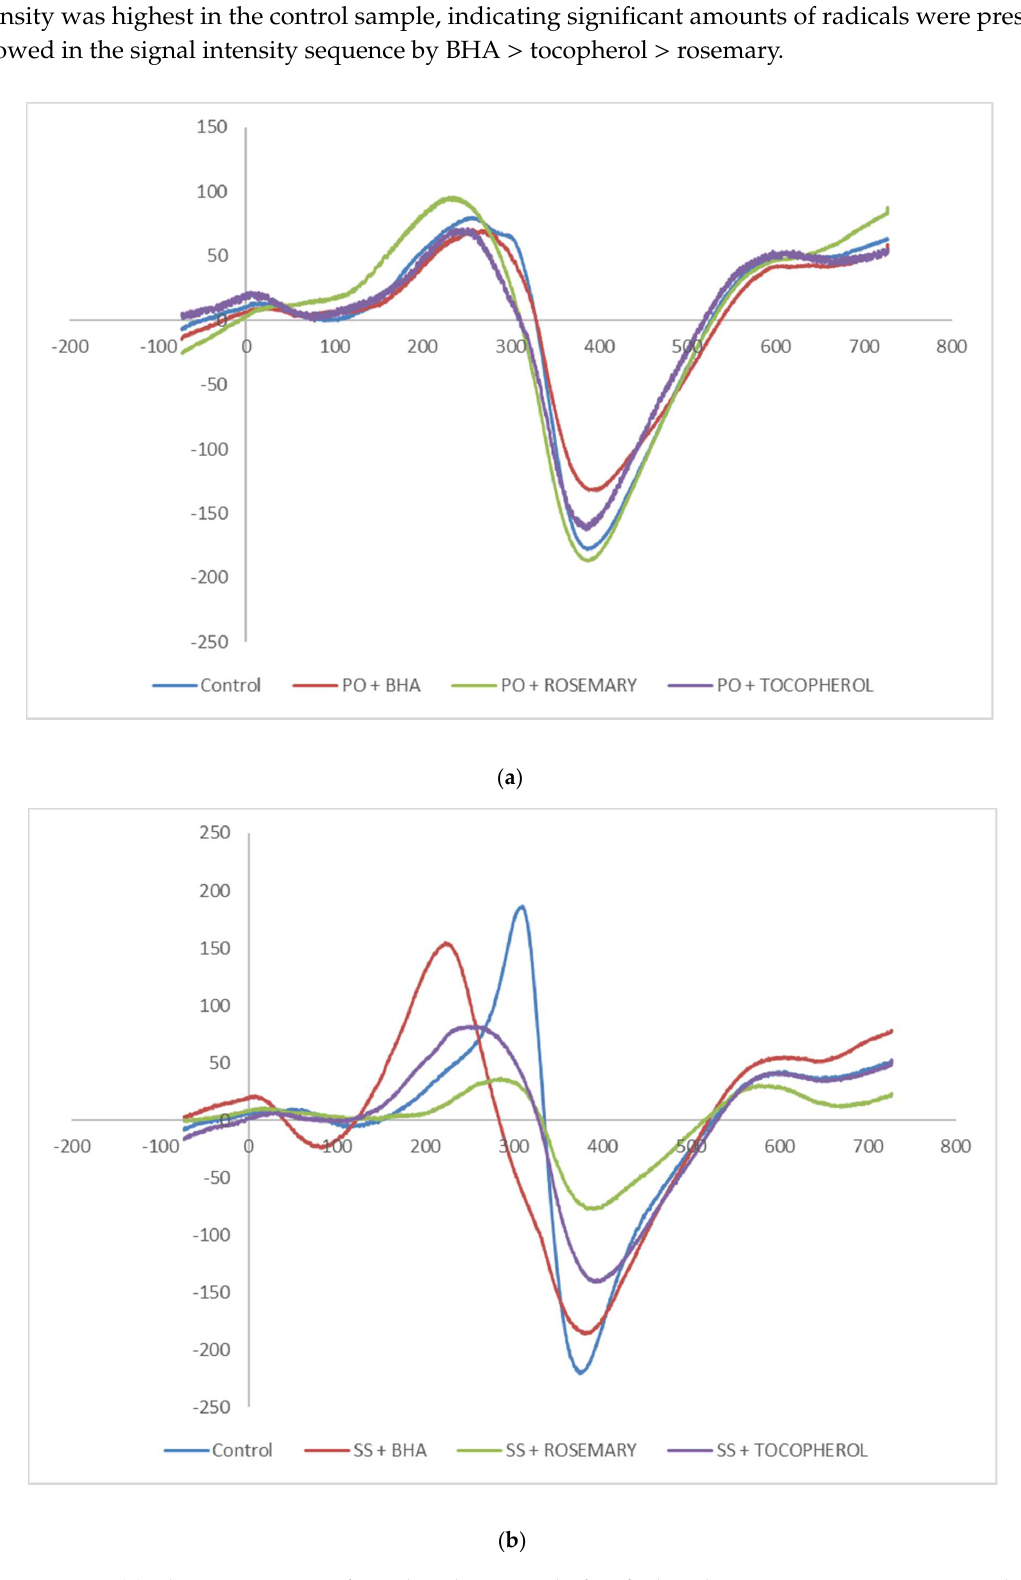
Figure 1. ( a ) The ESR spectra of a palm olein sample fortified with BHA, rosemary extract and tocopherol at 200 mg / kg and the control (no antioxidant); ( b ) the ESR spectra of a soft stearin sample fortified with BHA, rosemary extract and tocopherol at 200 mg / kg and the control (no antioxidant).